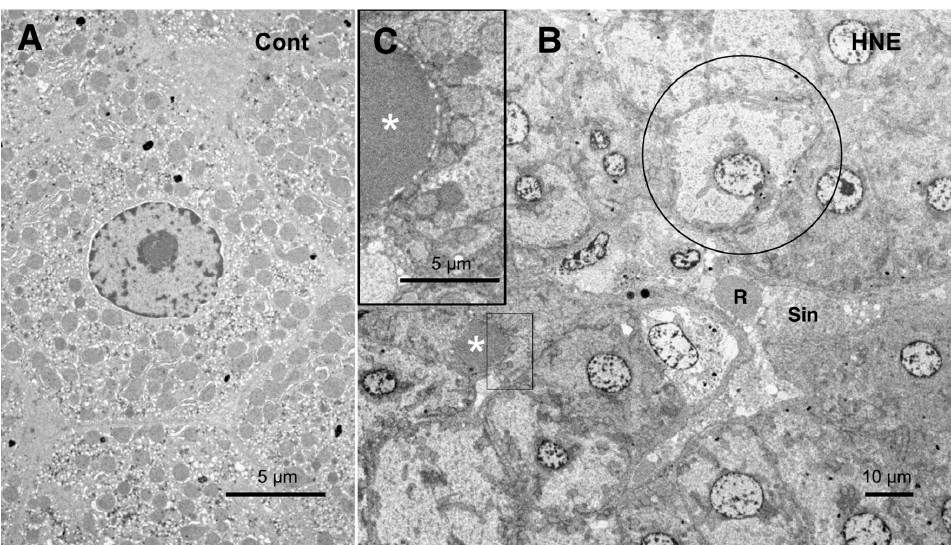
Figure 10. Electron microphotographs of the control hepatocytes ( A ) and degenerating hepatocytes ( B , C ) after the hydroxynonenal (HNE) injections. The normal hepatocytes ( A ) were characterized by numerous mitochondria. Compared to the control ( A ), the hepatocytes after the hydroxynonenal (HNE) injections ( B ) exhibited a diverse degree of degeneration after the hydroxynonenal injections; the extent of degeneration was inverse to the electron density of the cytoplasm. The electron-luscent hepatocyte (( B ), circle) indicates a remarkable degeneration of the cytoplasm as seen in the light microscopy analysis (Figure 2B). A small lipid droplet, as observed via T-B staining (Figure 3B, arrows), formed among the degenerating hepatocytes (( B , C ), white asterisks). The rectangle in ( B ) is enlarged in ( C ). R: red blood cell; Sin: sinusoidal